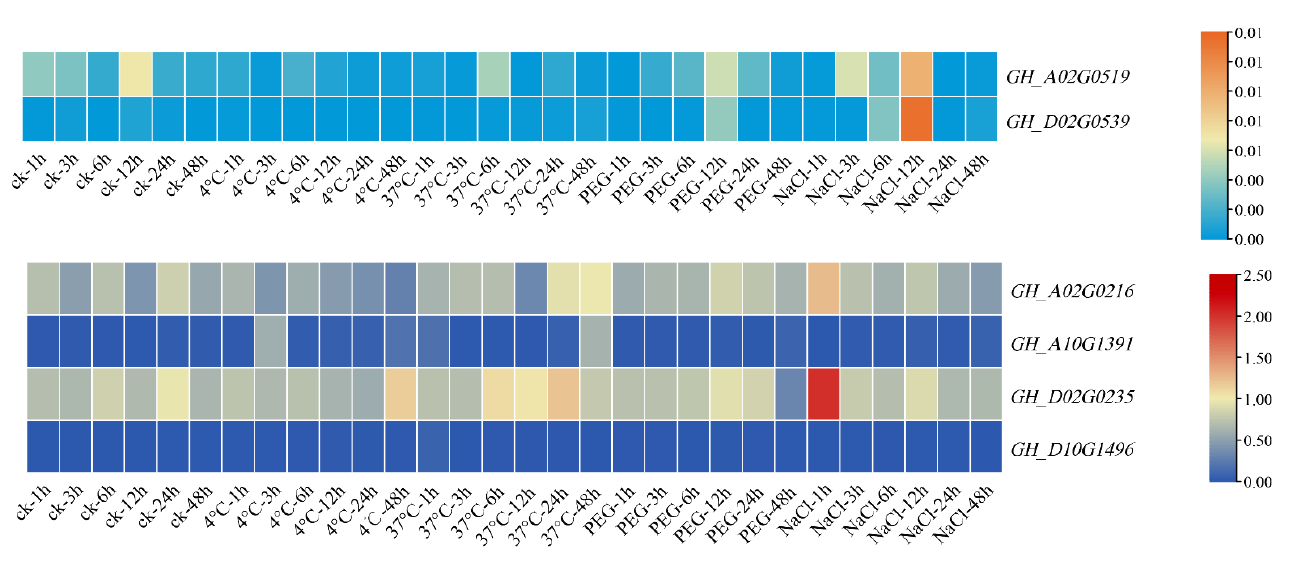
Figure 10. Heat map of Filamin gene family members in upland cotton expression under different abiotic stresses.